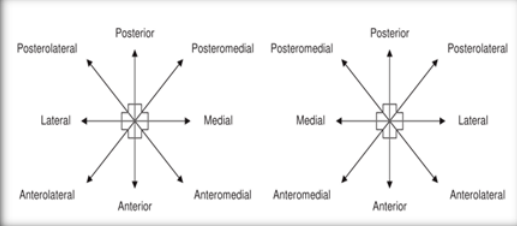
Figure 1. Reaching directions of Star Excursion Balance Test